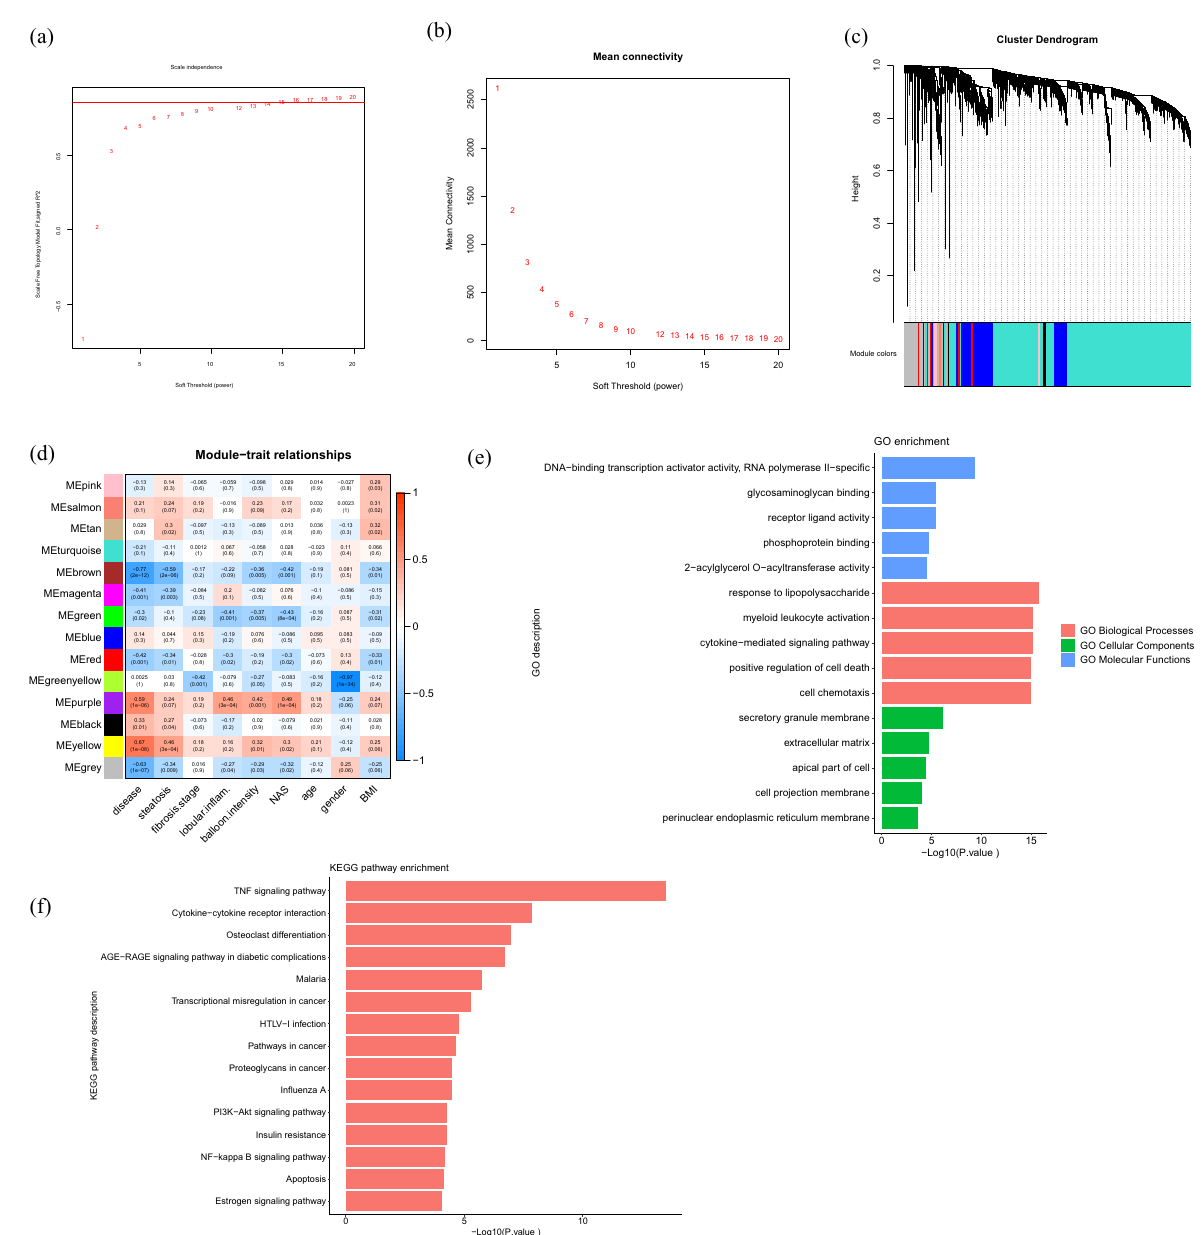
Figure 2: Construction of weighted gene co - expression modules and the relationship between module and trait. ( a ) Analysis of the soft threshold, red line = 0.85. ( b ) Analysis of mean connectivity. ( c ) Cluster dendrogram based on the dataset GSE89632. Di ff erent colors represented di ff erent co - expression gene modules. ( d ) Heatmap of the relationship between module and clinical trait. Each column represented clinical data, and each row represented each co - expression module. Each small grid stood for each pair of the module and trait, and indicated correlation index and p - value. Blue and red represented negative correlation and positive correlation, respectively. The deeper the color of the grid, the stronger the correlation. ( e ) Top fi ve signi fi cant GO MFs, BPs, and CCs enriched by genes in brown and yellow modules. ( f ) KEGG pathway enriched by genes in brown and yellow modules ( top 15 )